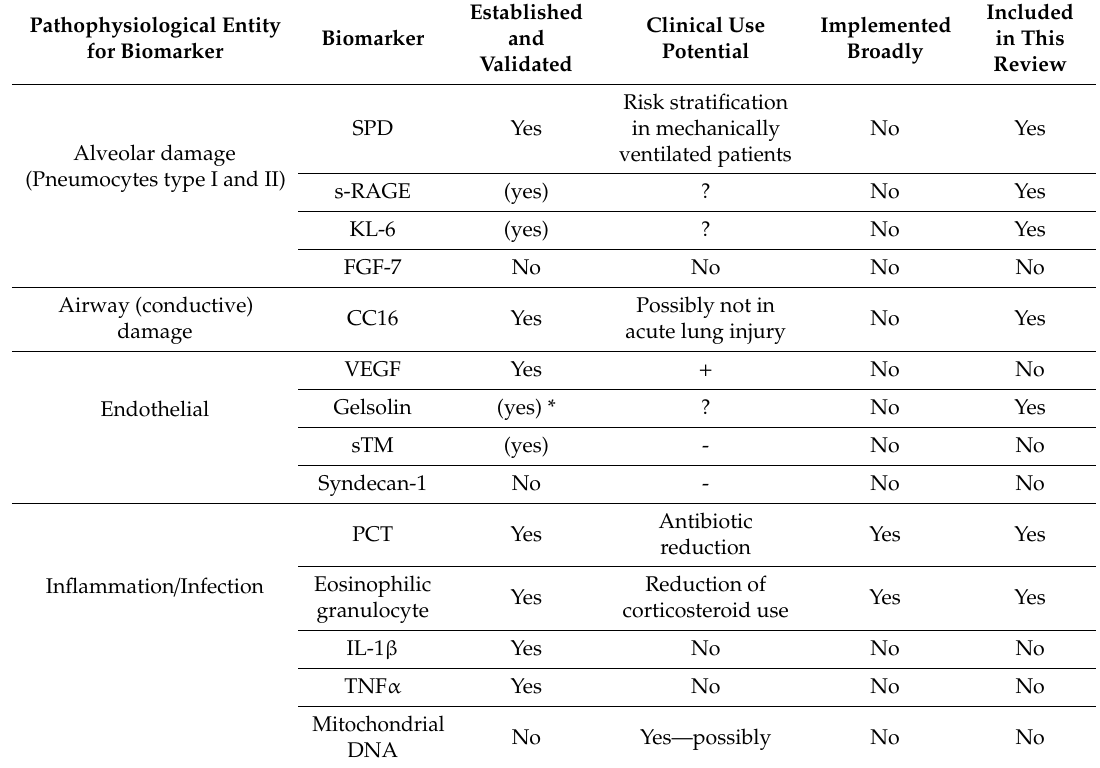
Table 1. Candidate and established biomarkers of acute lung